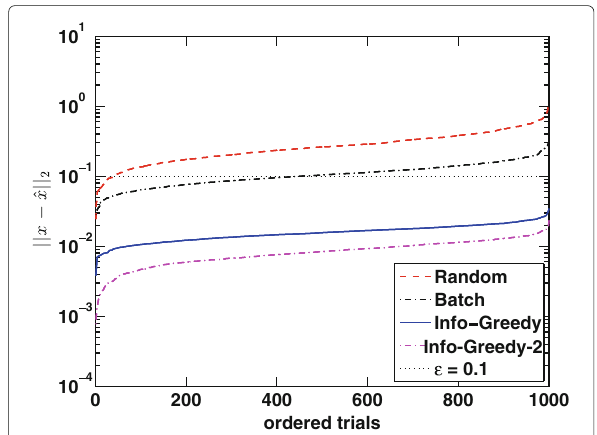
Fig. 3 Sensing a Gaussian signal of dimension n = 100, when there is mismatch between the assumed covariance matrix and the true covariance matrix: (cid:2) (cid:2) ∝ (cid:2) + RR (cid:2) , where R ∈ R n × 3 and each entry of R ij ∼ N ( 0,1 ) . We repeat 1000 Monte Carlo trials, and for each trial, we use K = 20 measurements. The Info-Greedy-2 method corresponds to (2), where we update the assumed covariance matrix sequentially each time we recover a signal and α = 0.5